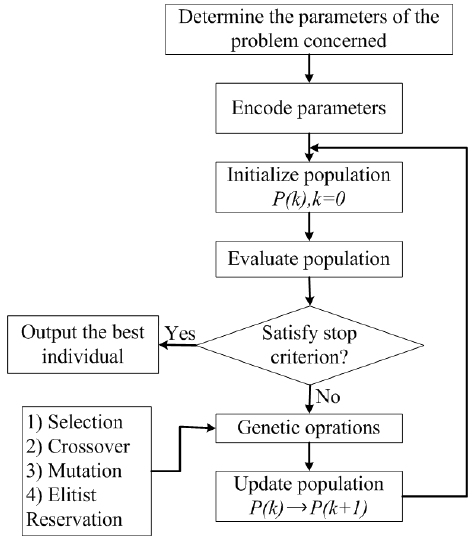
Figure 9. The flow chart of the GA.